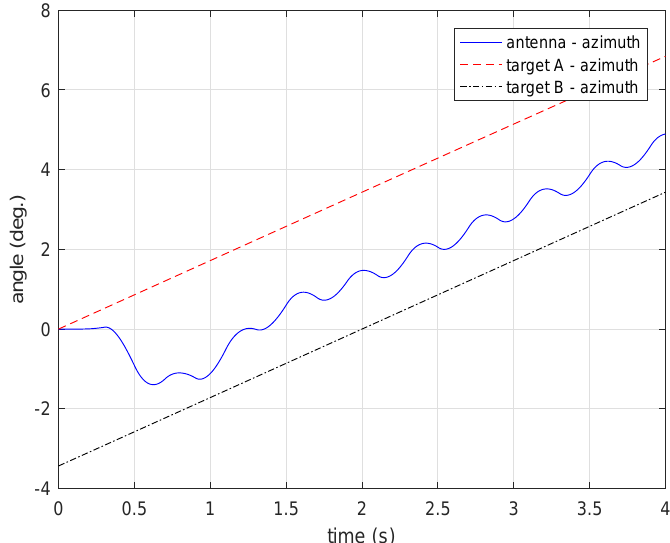
Figure 20. The azimuth to targets A and B compared to the antenna’s pointing angle during the blink jamming